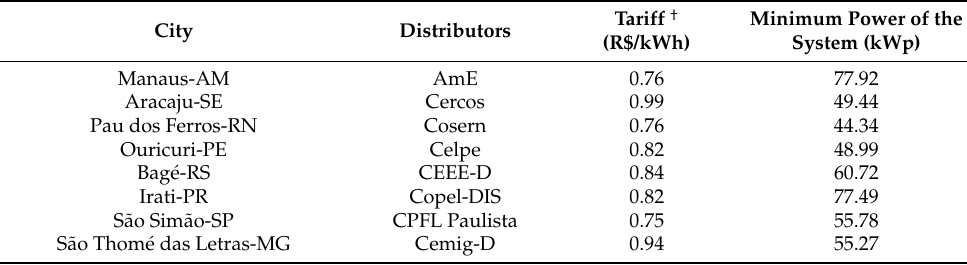
Table 4. Values of tariffs and minimum power of the systems for the analyzed